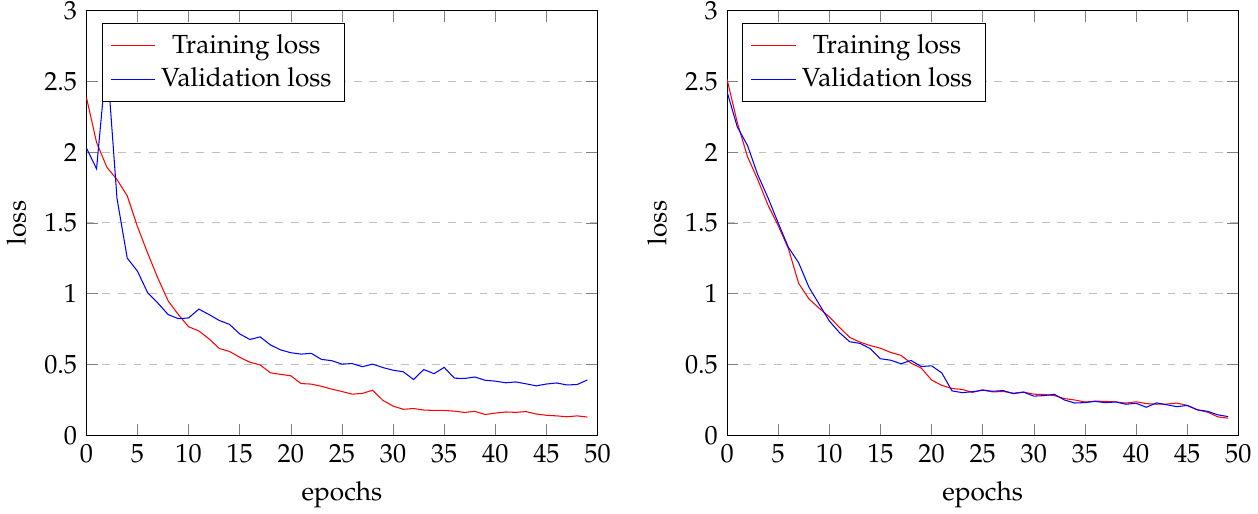
Figure 7. Training and validation losses for instruction-based ( left ) and opcode-based ( right ) models. Figure 8 is the visualization of opcodes sequence for each function. First, functions that perform the same operation show almost similar patterns, and different functions have different patterns. We can see that rotation functions of SIMON and SPARX have a very similar sequence. In addition, the same pattern is repeated in the function. Figure 9 shows the frequency of opcodes for each algorithm. These images can be represented in an array with 256 columns. Therefore, each index represents an opcode, and elements of this array represent the number of times the opcode is used. The opcode used is represented by the vertical line in these Figures. Therefore, it is visually revealed that the distribution of opcodes is different for each structure through the location and contrast of the lines. In the gray scale, 0 means black, and 255 means white. The frequency was normalized to be within the range. The line of color closer to white is the more used opcode. The comparison is made between Figure 9 and Table 6. The most commonly used operations, such as LD, ST , and MOVW , are 129, 131, and 1, respectively. The middle of the images is expressed